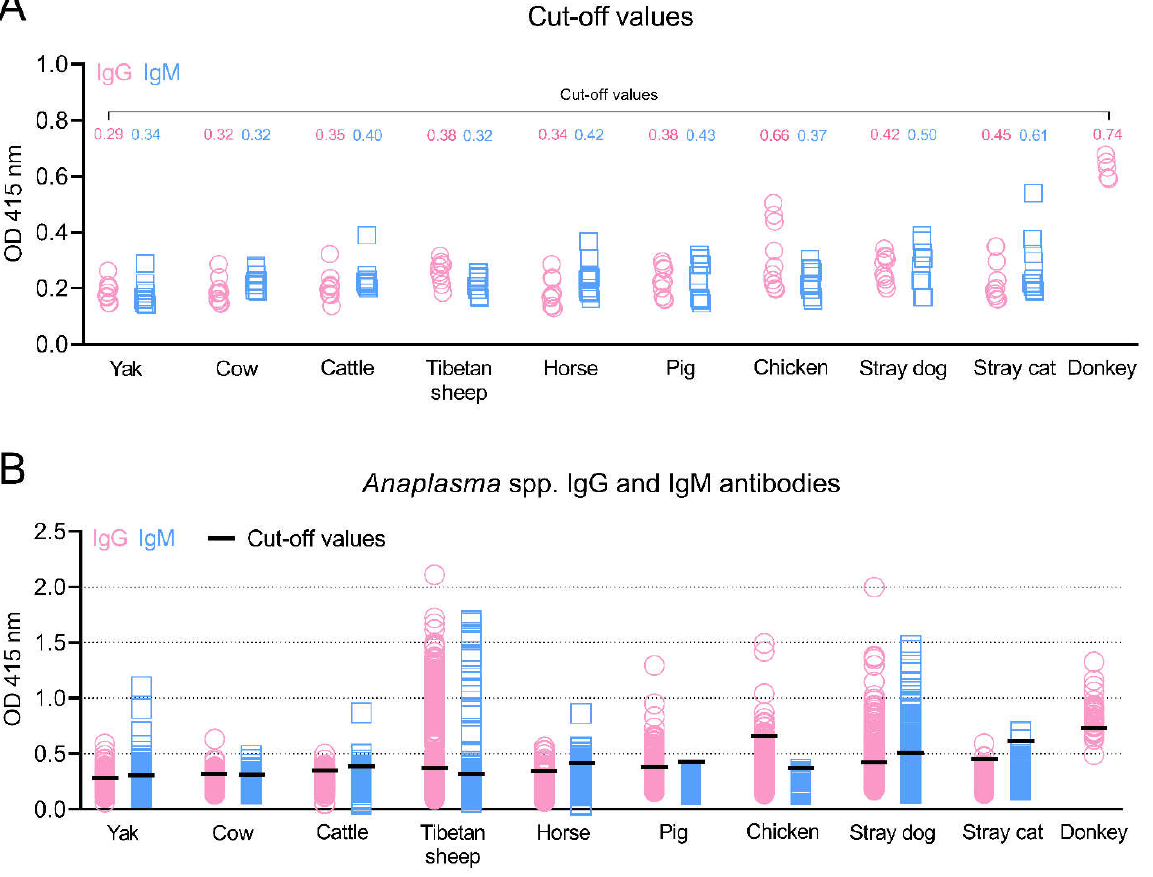
Figure 2. Anaplasma spp. IgG and IgM antibodies in various animals in the Qinghai–Tibet Plateau Area were detected by the indirect ELISA methods based on MSP5 antigens in this study. The cut-off values ( A ) and positive animals for IgG and IgM antibodies ( B ) are shown. OD: Optical Density.